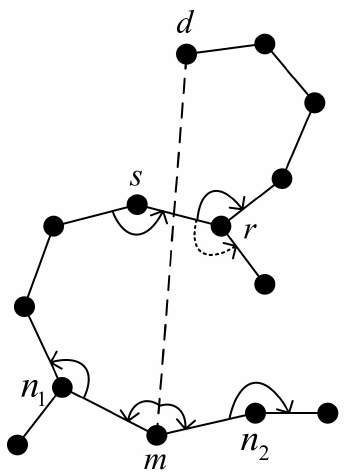
Figure 13. An example of DAF